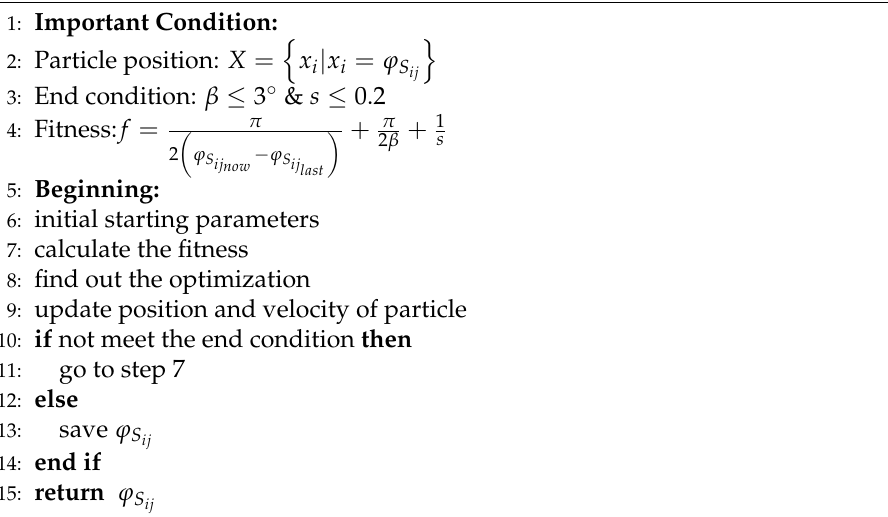
Algorithm 2 ϕ S calculated by particle swarm optimization ij